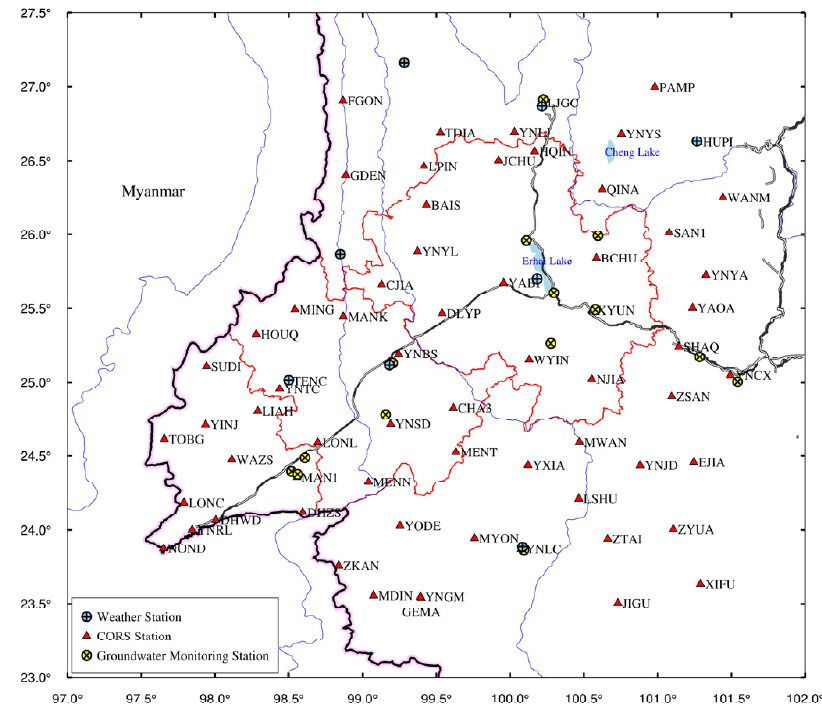
Figure 1. Geographic location of the study region.